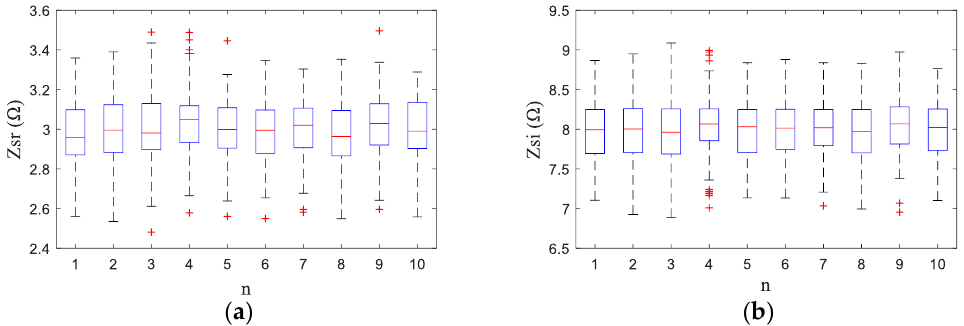
Figure 4. Results of method 1 in simulation I. ( a ) The result of the real part; ( b ) The result of the imaginary part.